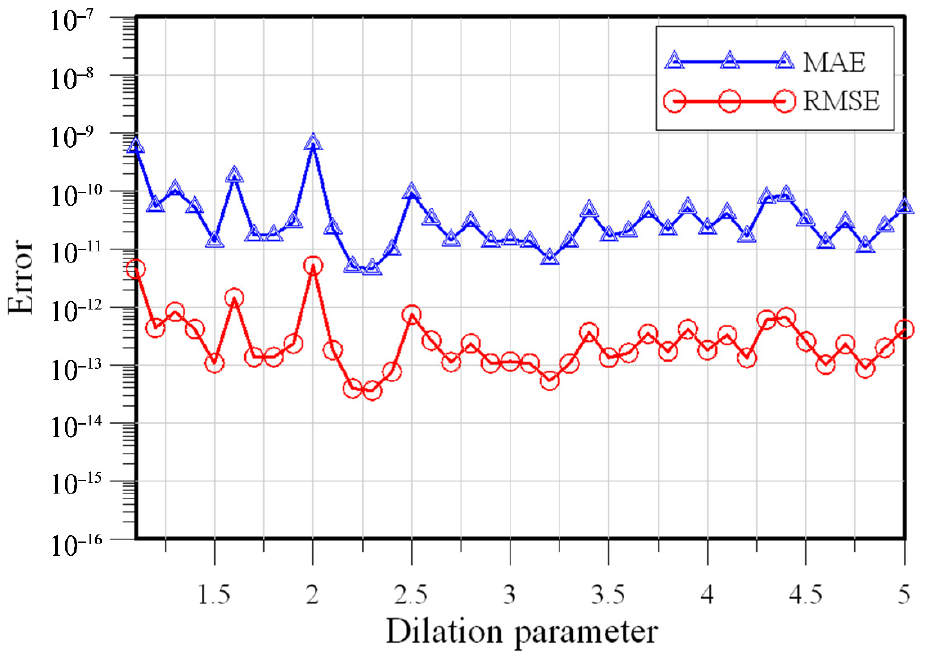
Figure 8. Error versus the terms the PPRBF.